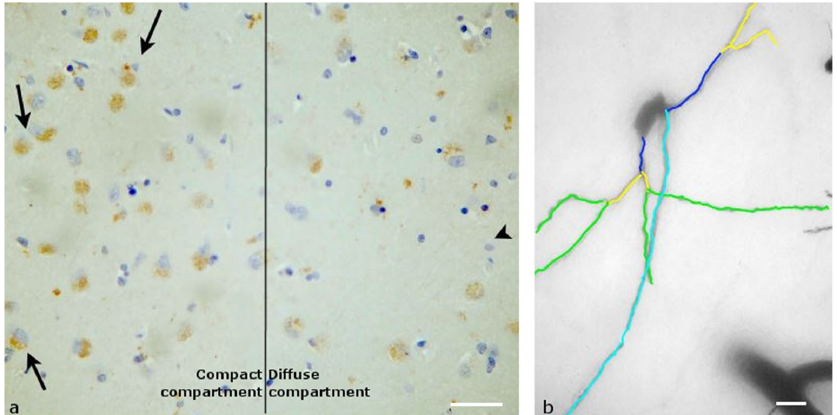
Figure 3. Dorsomedial nucleus of the human Hypothalamus: ( a ) Immunohistochemical staining, specific for OX1R. On the left of the photo is the compact compartment, with large neurons that are immunopositive (black arrow), and on the right of the photo is the diffuse compartment, with mainly smaller, non-immunopositive neurons (arrowhead) (Scale bar, 50 μ m); ( b ) A Golgi-stained neuron of the compact compartment mapped by the ImageJ program. Primary (dark blue), secondary (yellow) and tertiary (green) dendrites can be found. Light blue depicts the axon of the neuron, which moves towards the lateral hypothalamic area (Scale bar, 10 μ m).